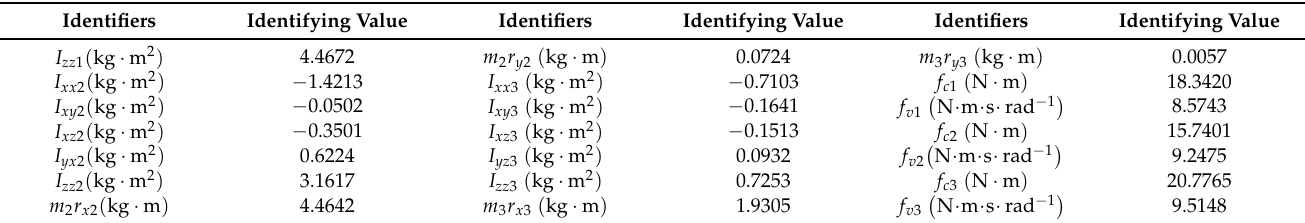
Table 2. Results of the identification of robot dynamics